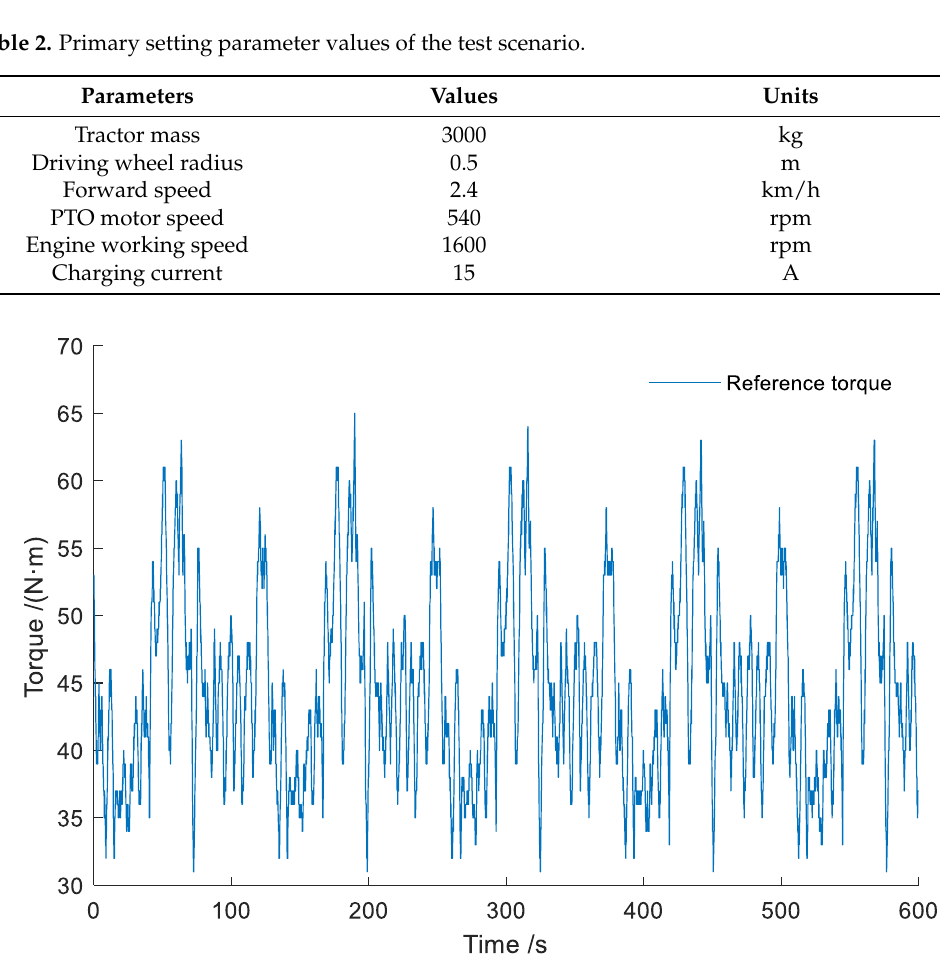
Figure 8. The curve of the power takeoff (PTO) reference torque